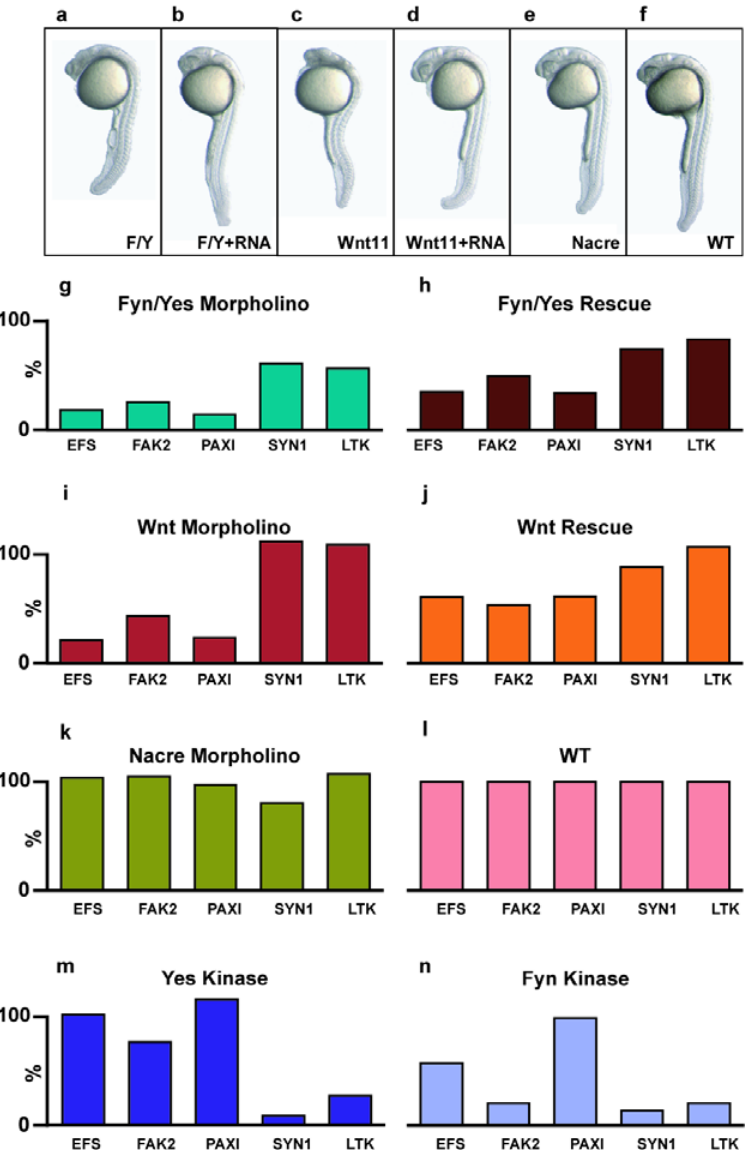
Figure 2. Similarities in PTK activity profiles of Fyn/Yes and Wnt11 knock downs. (a–f) Morphology of 24 hpf zebrafish embryos after knock down of Fyn/Yes (F/Y), Wnt11 or Nacre and of recues of the indicated knock downs using the corresponding synthetic RNAs. (g–l) Relative intensities of phosphorylation of a selection of five peptides. The signal was determined in duplicate and calculated relative to non-injected wild type control (set to 100%). (m–n) Relative intensities of phosphorylation of the same set of five peptides by purified Yes and Fyn kinases.